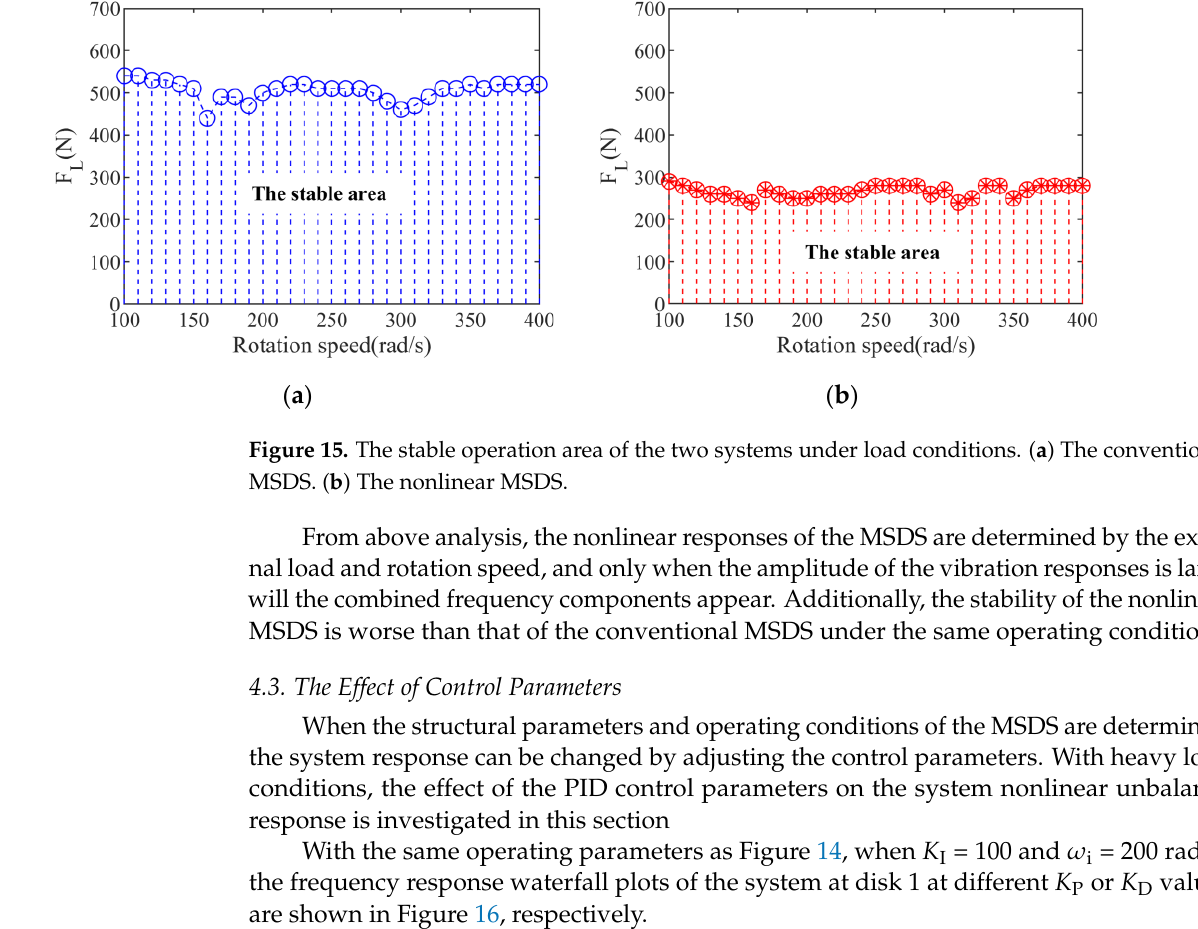
Figure 16. Waterfall plots of frequency responses of disk1 under different control parameters. ( a ) KP; ( b ) KD.